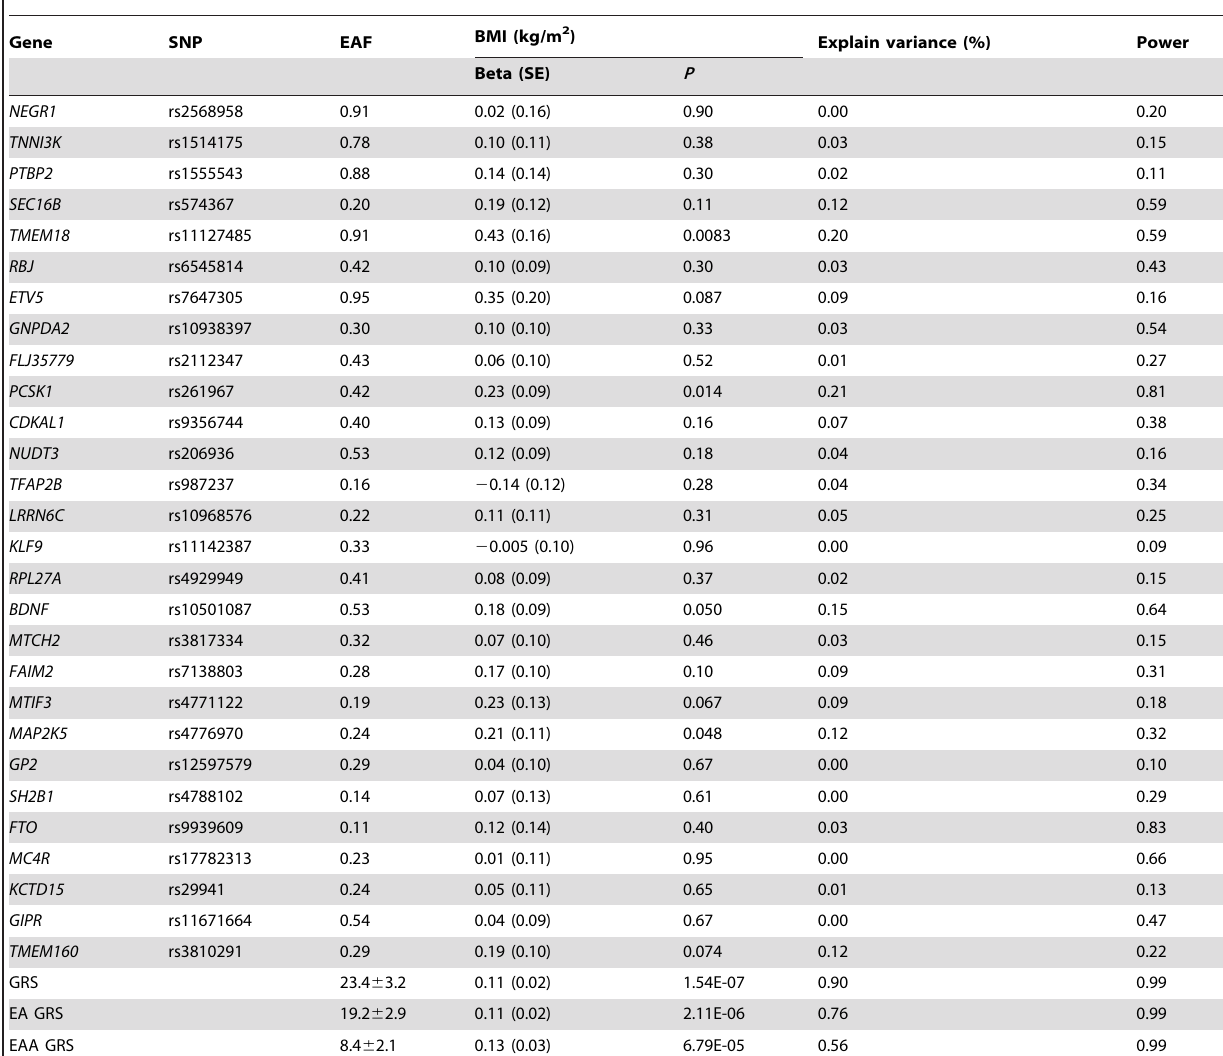
Table 1. Associations of individual SNPs and GRSs with BMI.